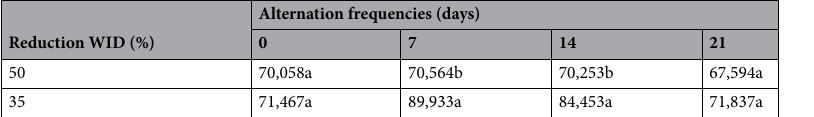
Table 5. Interaction between the frequency of alternation of the irrigated side versus the reduction of the WID for the yield variable, Bom Jesus da Lapa, Bahia, Brazil. Means followed by the same letter in the column do not differ statistically by Tukey test at 5% probability level.